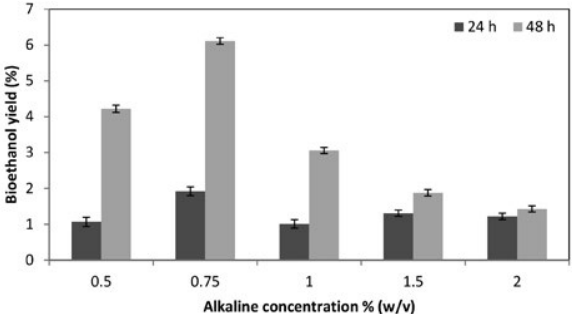
Fig 3. Bioethanol yield obtained after from alkaline pre-treated (at 100 °C, 60 min) microalgae